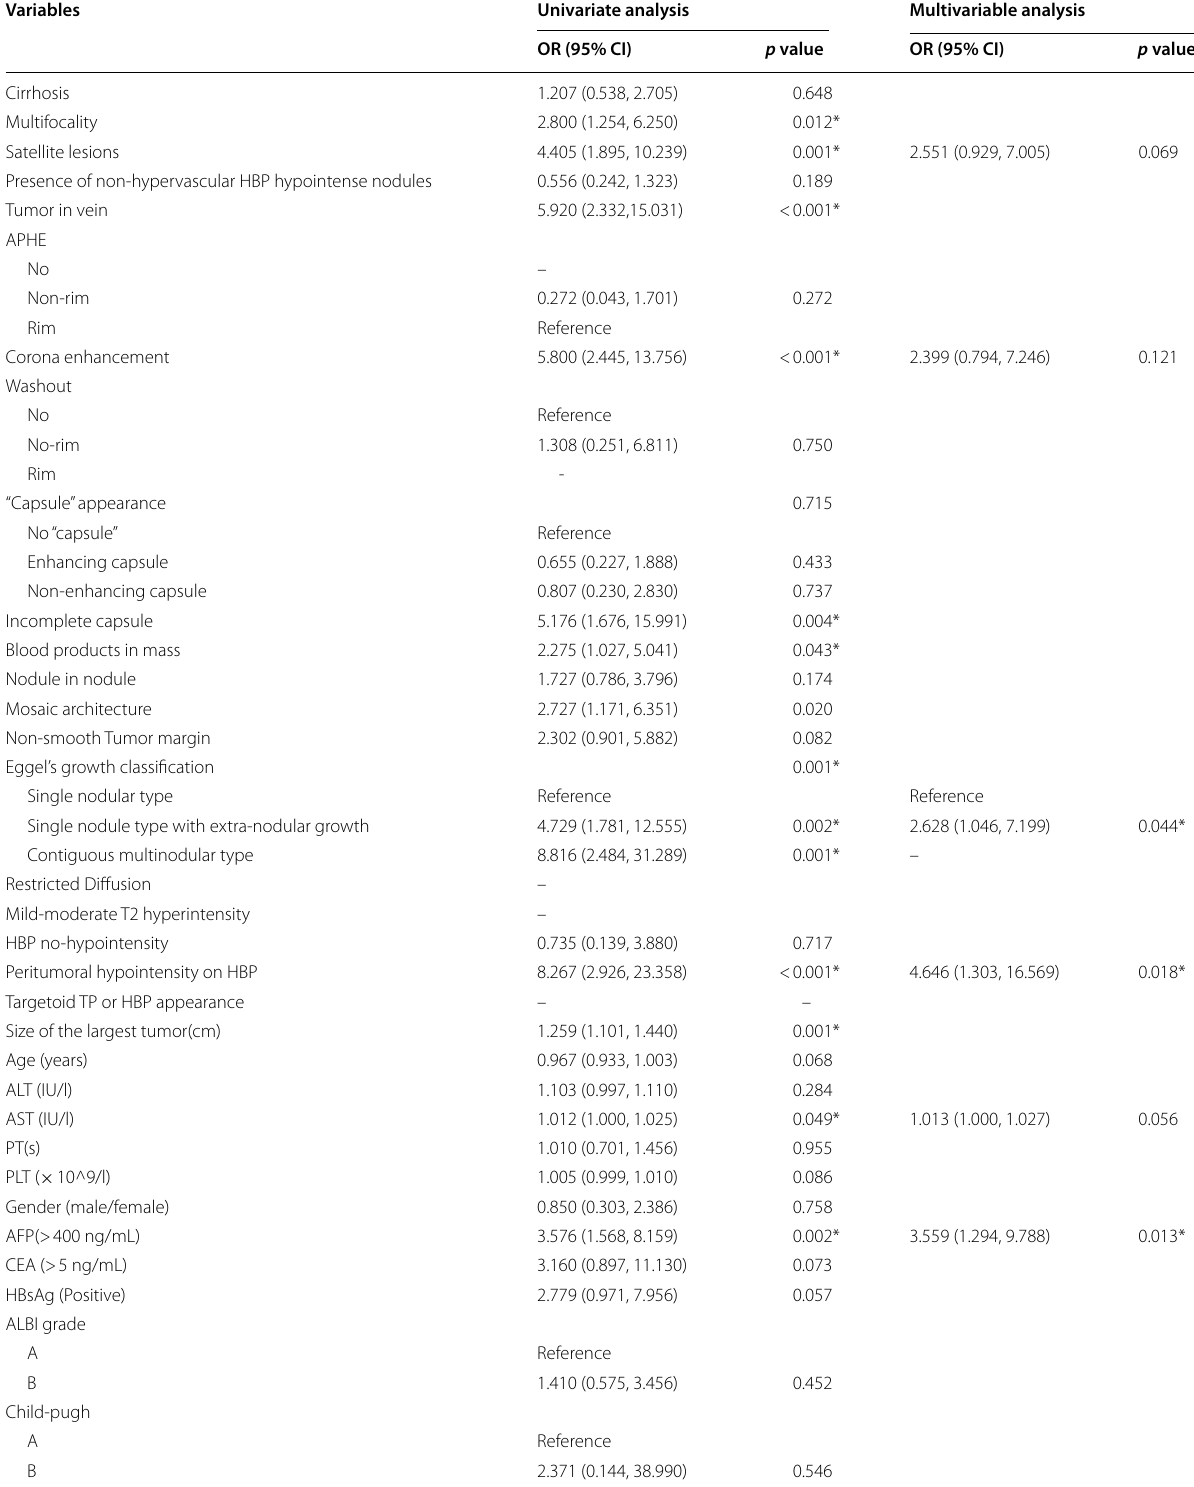
Table 3 Univariate and multivariate analysis results for early postoperative recurrence Variables Univariate